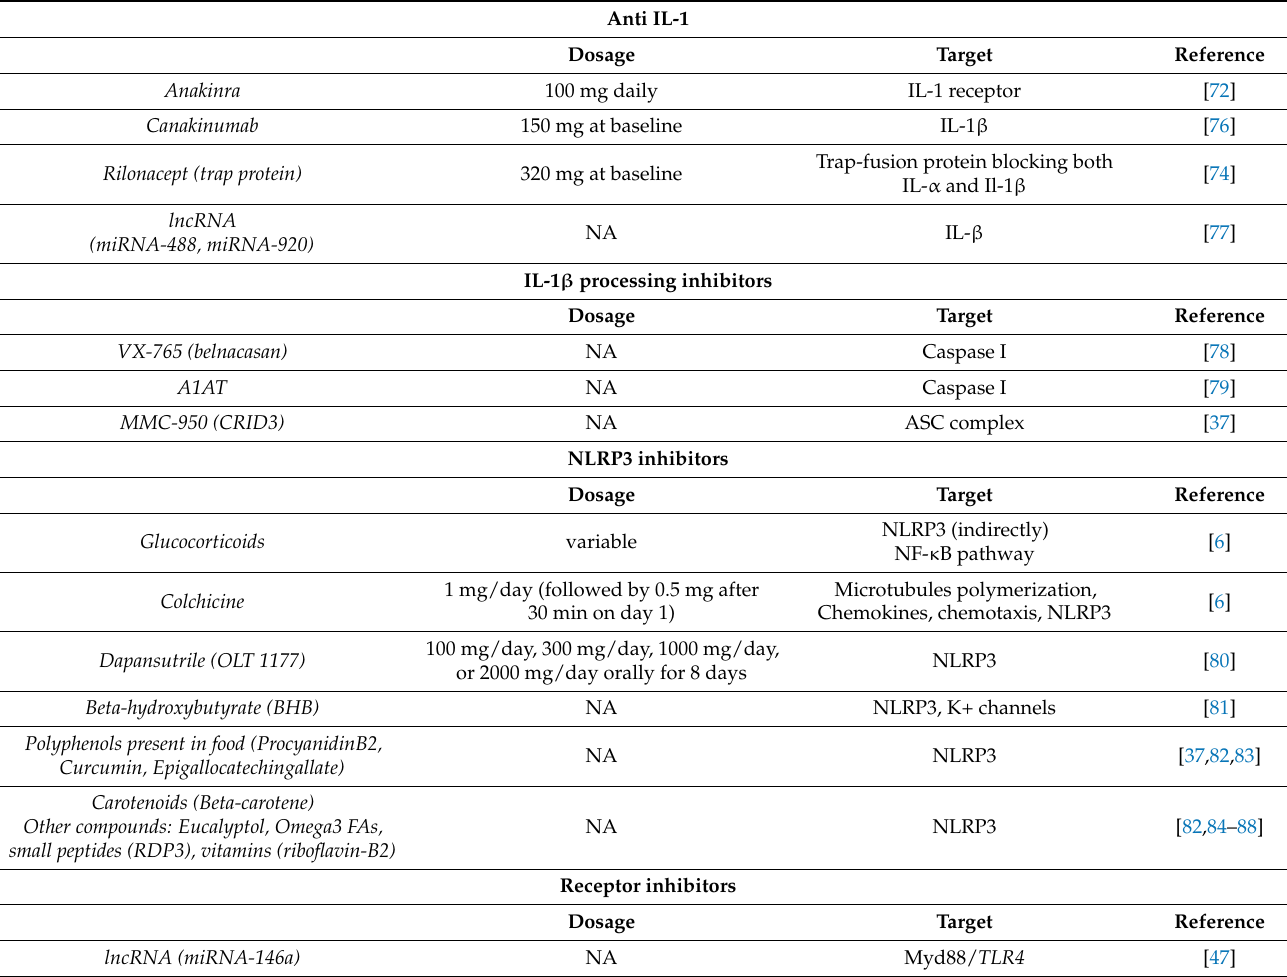
Table 1. Drugs and compounds proposed for gouty treatment targeting autoinflammatory